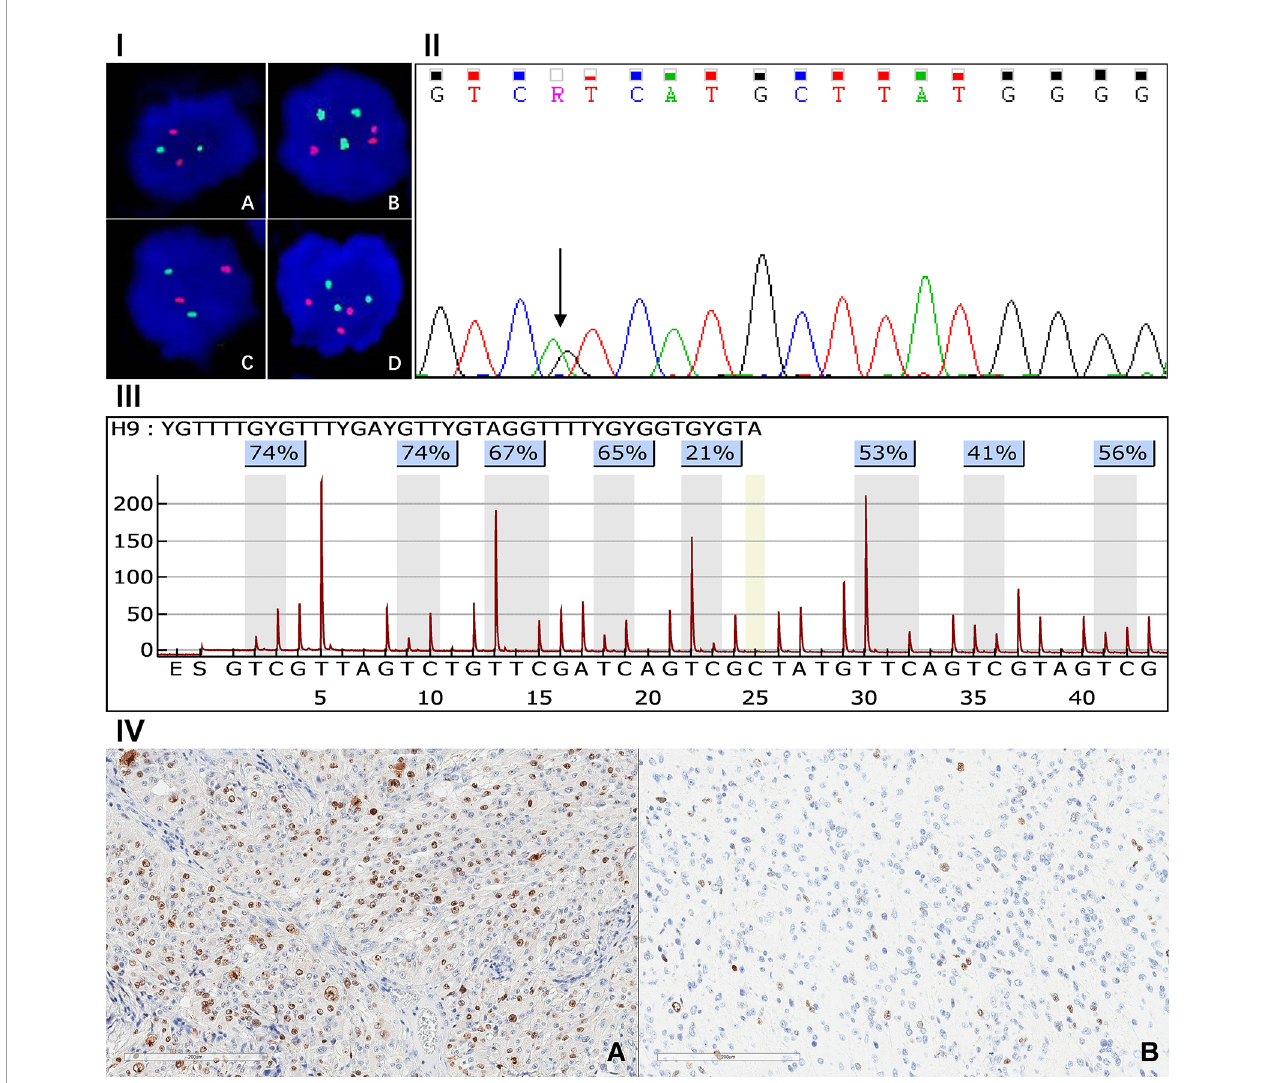
FIGURE 2 | Panel I, FISH detection result of 1q/19p polysomy: 1p intact (A) , 1q polysomy (B) , 19q intact (C) , 19p polysomy (D) . Panel II: Sanger sequence of IDH1 mutation. Panel III: Assay of MGMT promoter methylation in GBM. Panel IV: Immunohistochemical staining of high (A) and low (B) Ki-67